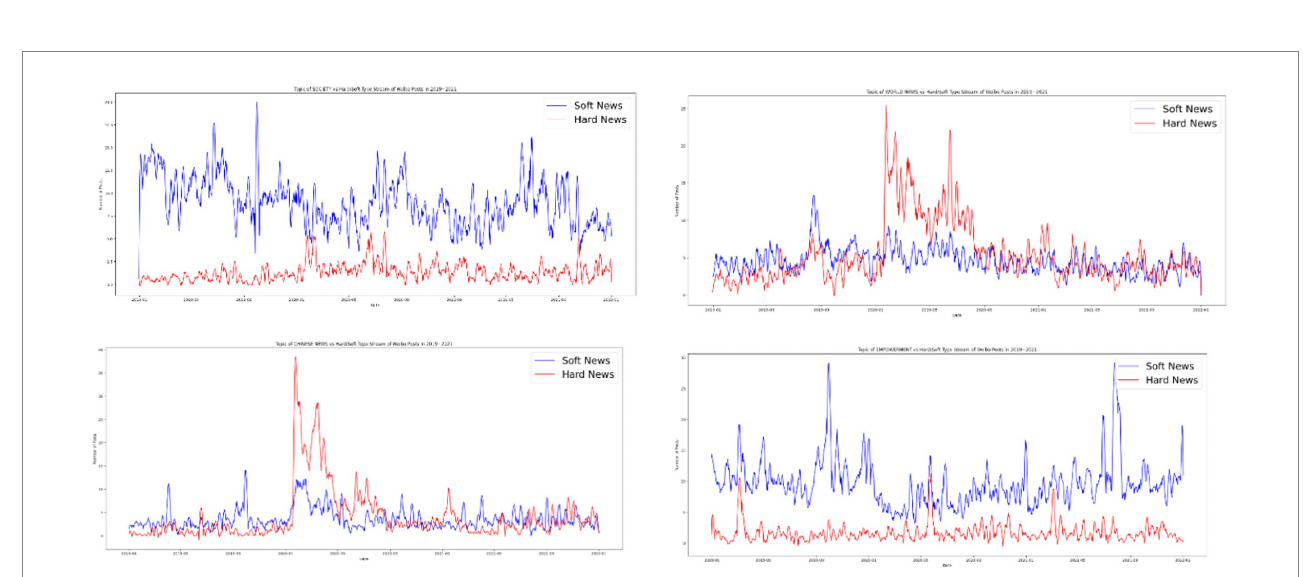
FIGURE 6 Hard news vs. soft news by topic over time; upper left, society; upper right, world news; lower left, Chinese political; lower right, positive energy.